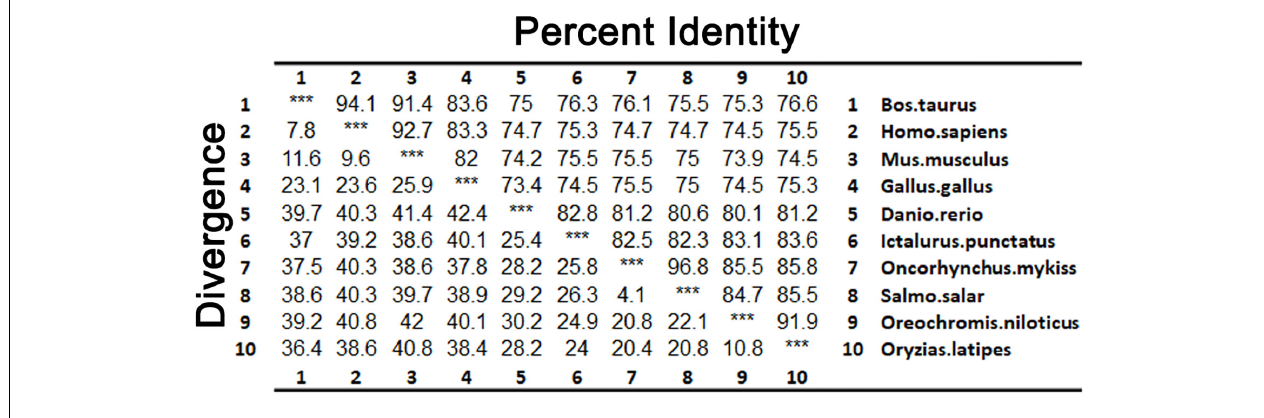
FIGURE 3 | Percentages (%) of amino acid sequence identity for LZTFL1 sequences.